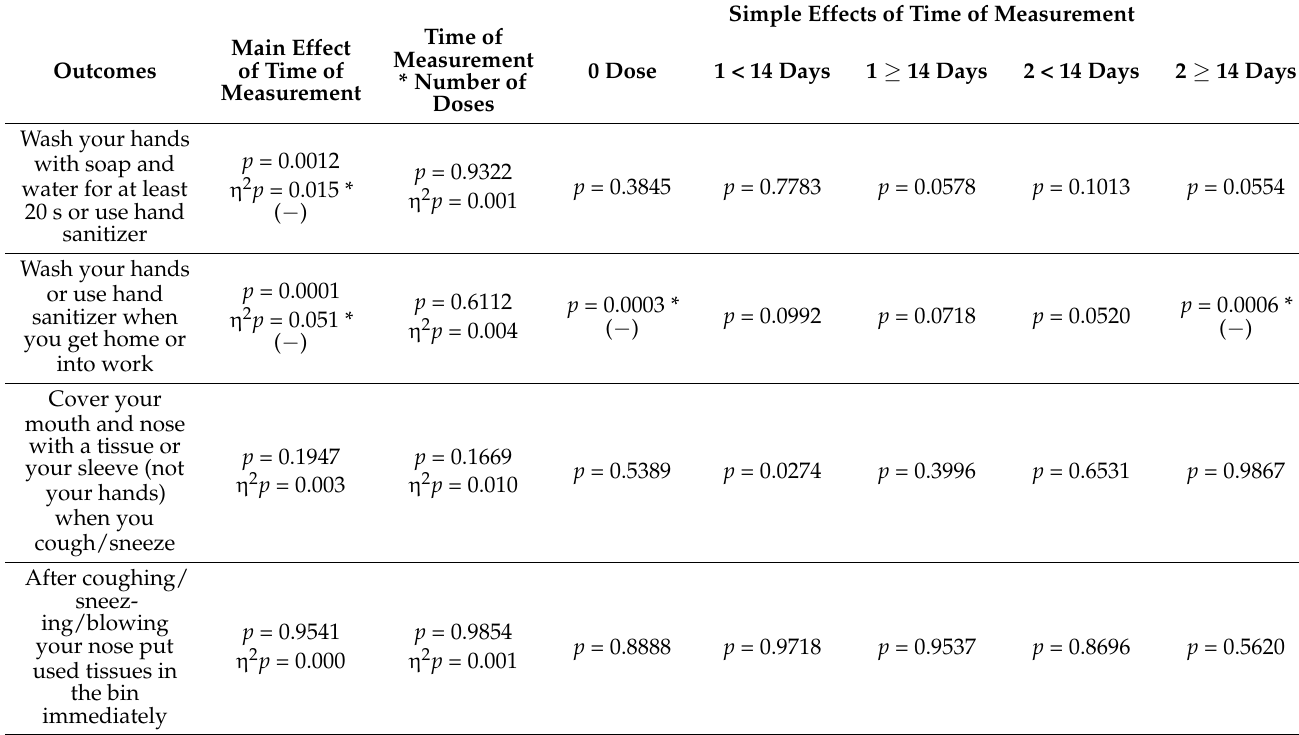
Table 2. Summary of the statistical